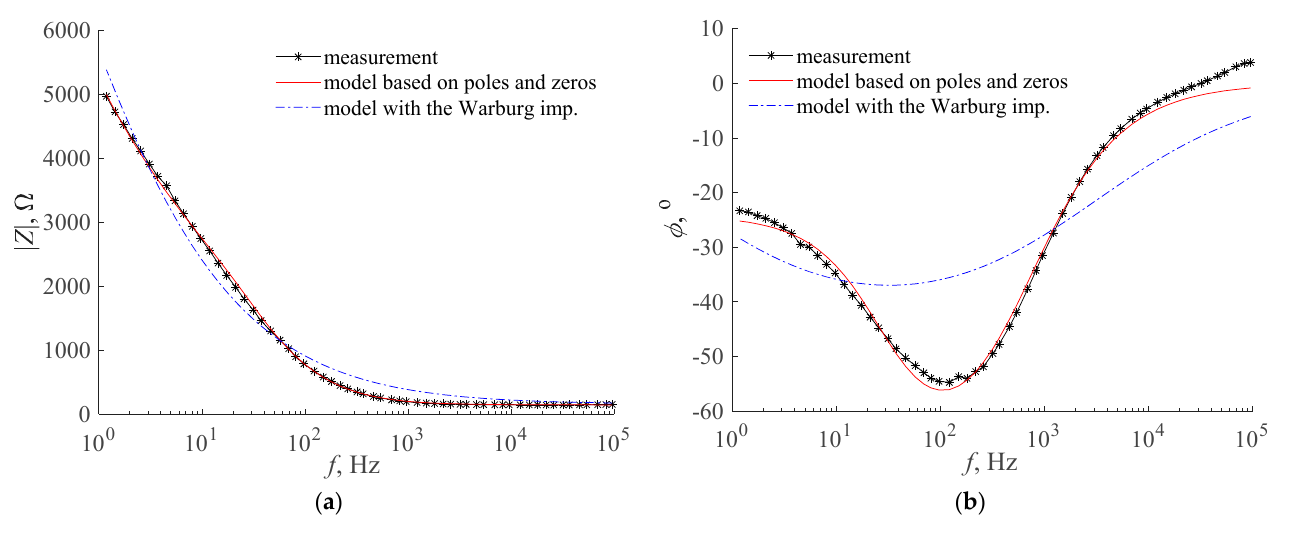
Figure 10. Measurement and approximating frequency characteristics of: ( a ) modulus and ( b ) argument of impedance of a symmetrical supercapacitor with collectors containing polypyrrole, containing LiClO 4 as an active electrolyte component.